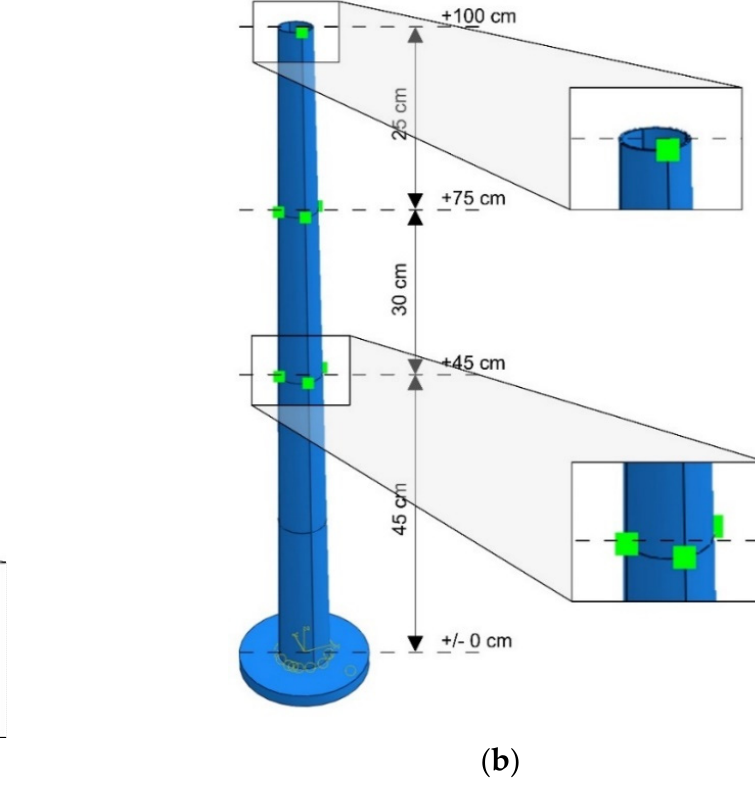
Figure 19. ( a ) The finite element model with the mesh details; ( b ) the additional masses assembly.